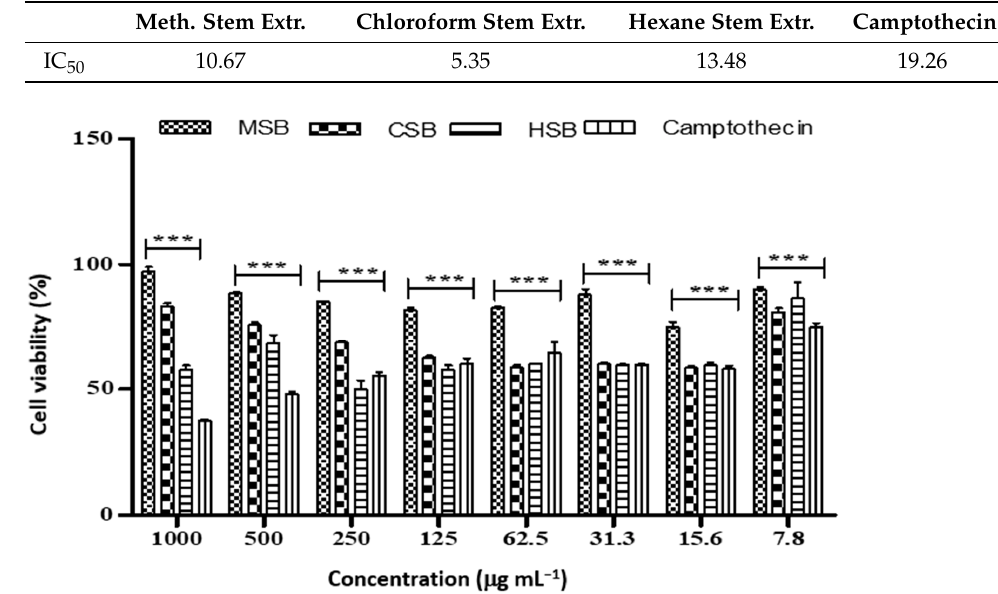
Table 10. IC 50 values of methanol, chloroform and hexane extract of D. villosa stem against A549 ceFll.